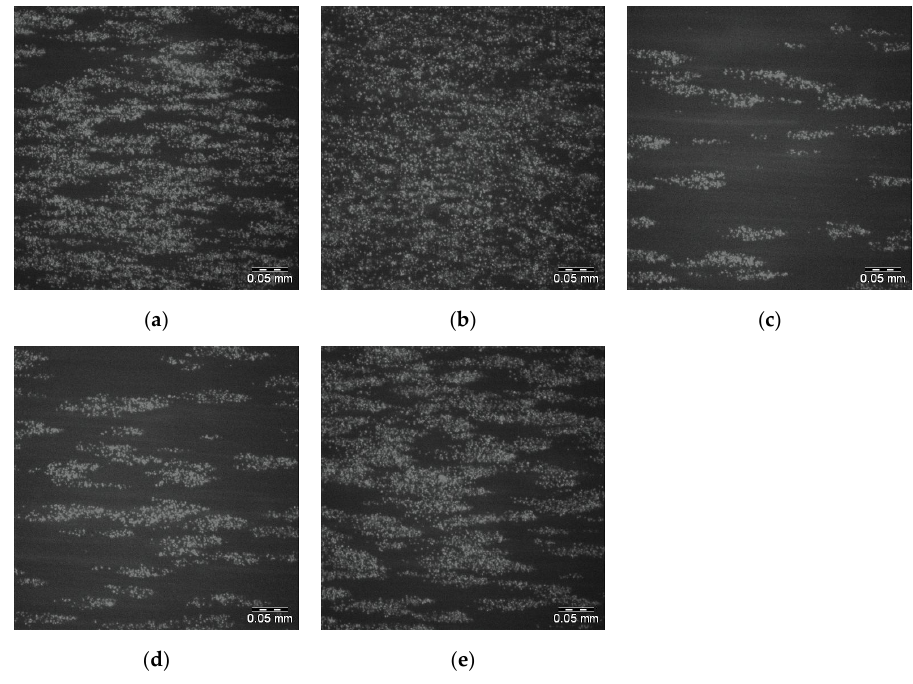
Figure 7. Fluoresence micrographs of whole blood DIOC 6 labelled platelets adhered to the surface of each of 5 replicates ( a – e ) of 25PS/75PMMA + 750 polymer demixed surface. Scale bar 0.05 mm.